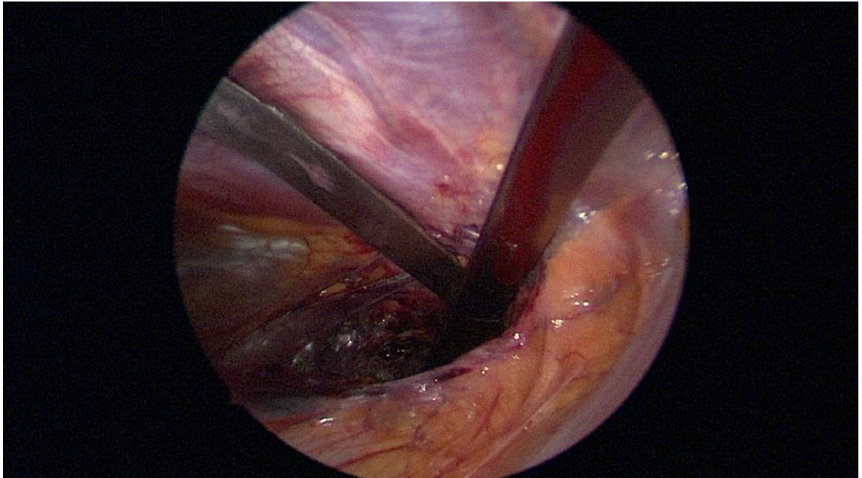
Figure 5. 17 years old male patient with PE and bilateral costal flaring, thoracoscopic view (Cross bar technique).